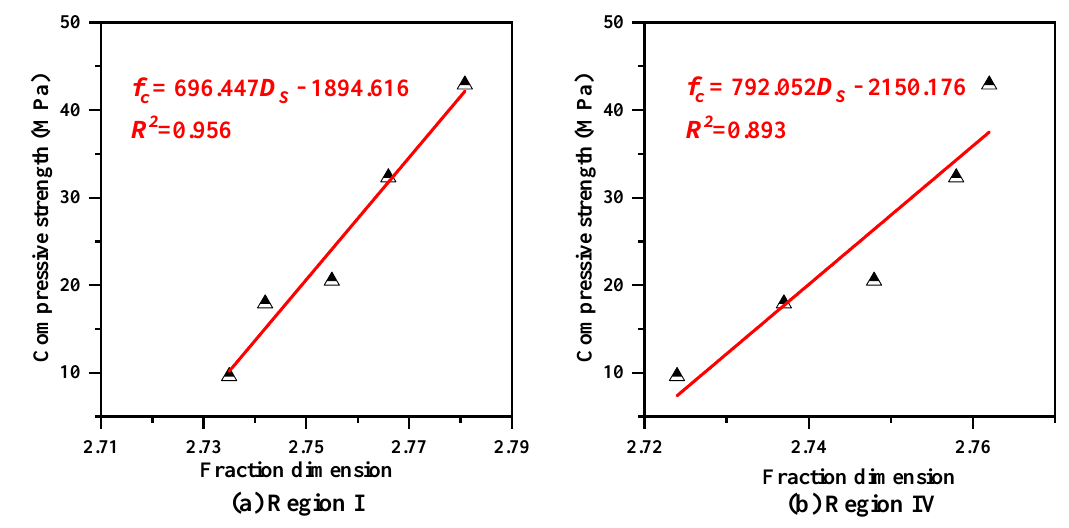
Figure 9. The relationship between compressive strength and fractal dimension.